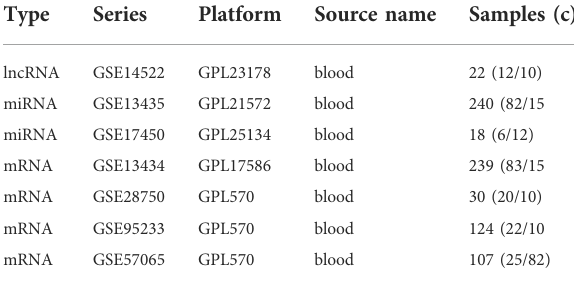
TABLE 1 Basic information of the 7 microarray datasets from